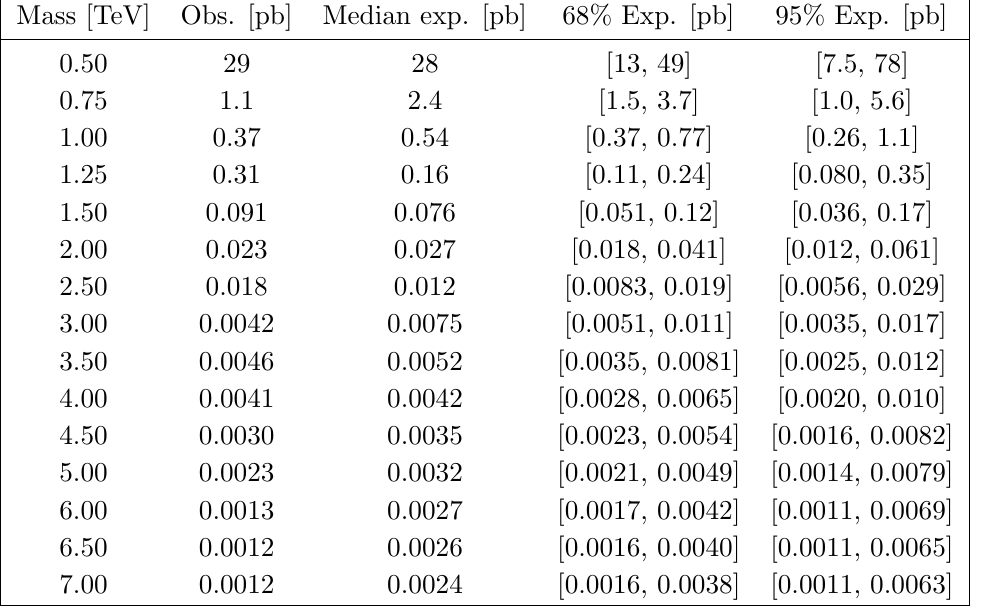
Table 2 . Limits at 95% CL on the product of the resonance production cross section and branching fraction for the narrow ((cid:0) =m = 1%) Z 0 boson resonance